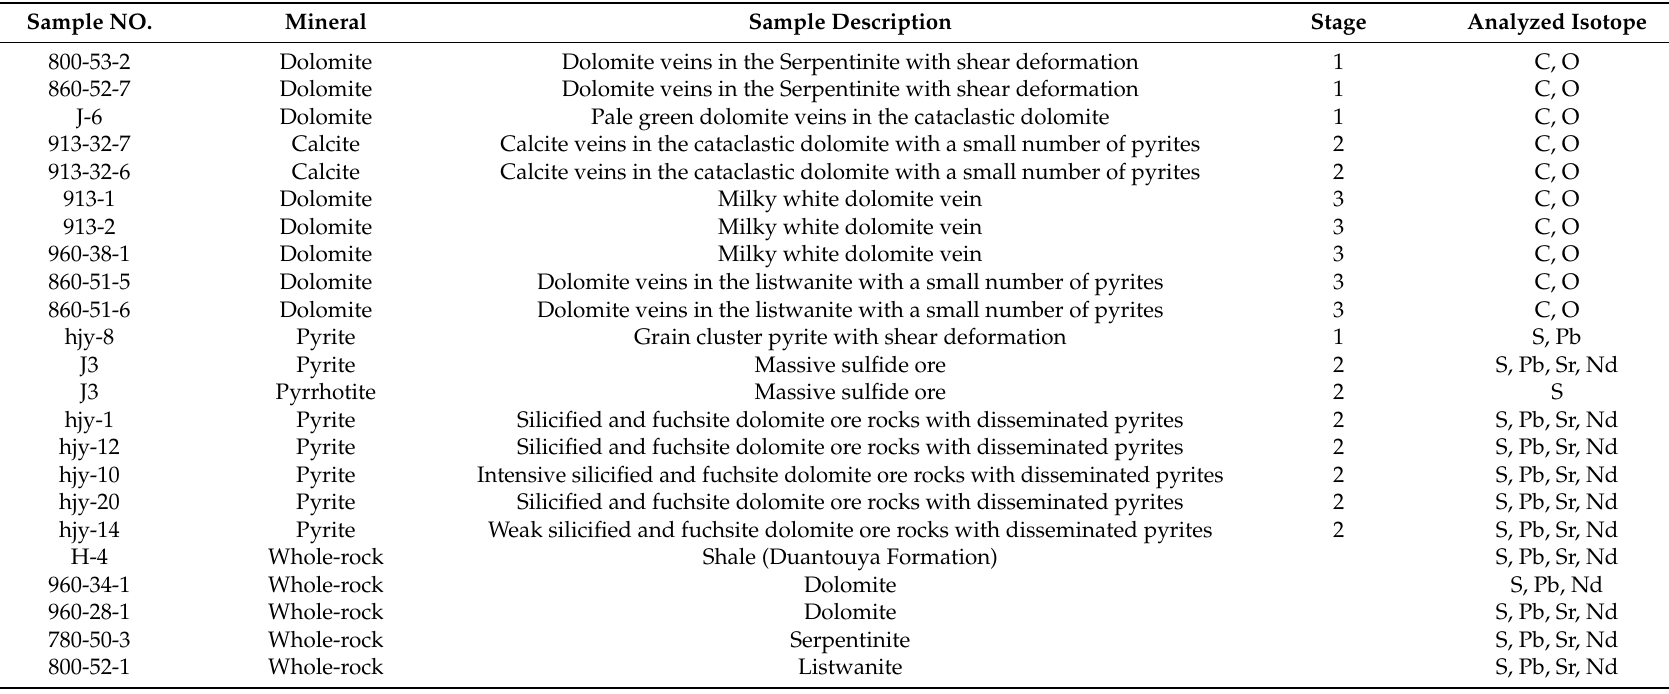
Table 1. The geological characteristics of samples from the Jianchaling Au deposit (modified from